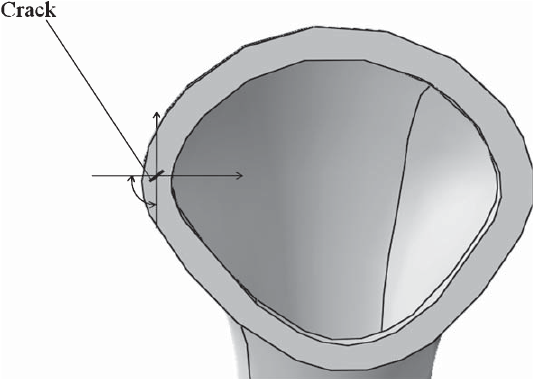
Fig. 14. The crack critical position and the range in which the crack is open.